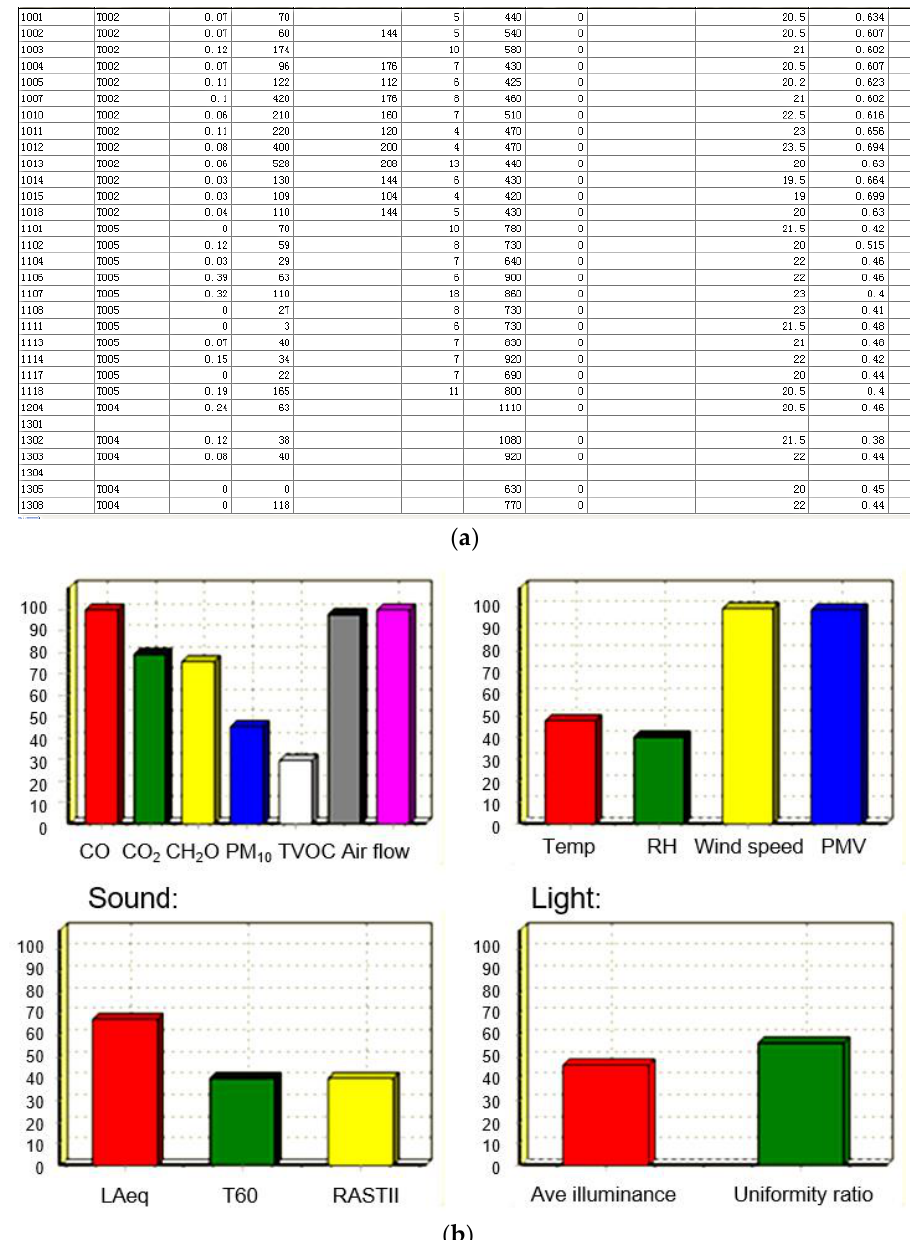
Figure 3. The Microsoft Delphi-based IEQ simulation tool of IEQ comprehensive health assessment: ( a ) database; ( b ) modeling results. ( a ) database; ( b ) modeling